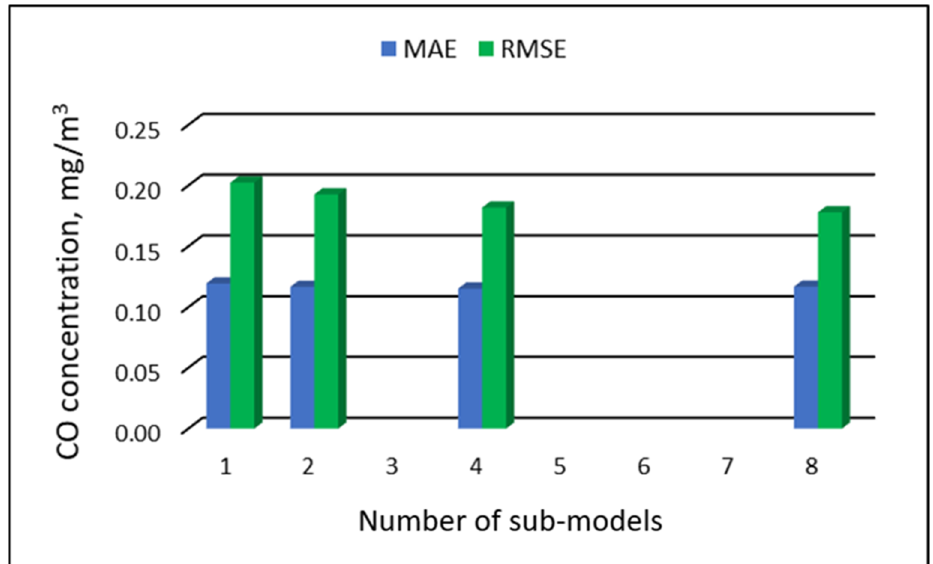
Table 24. Values of approximation errors of CO concentrations in RVS models, Zabrze 2011–2016.